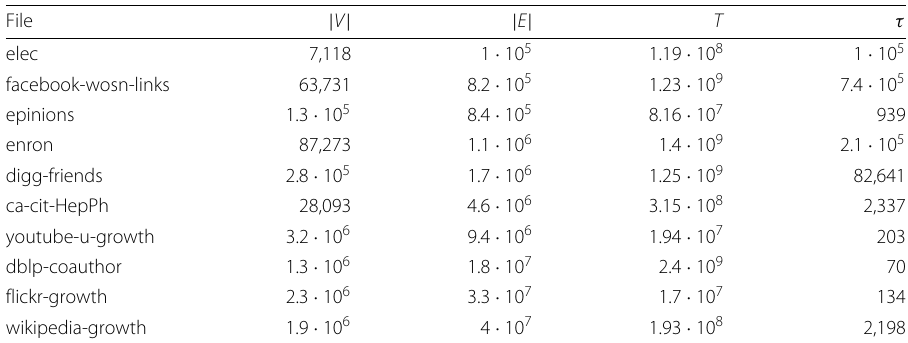
Table 2 Statistics for the real-world data sets used in our experiments (same freely available data sets as used by Wu et al. (2016), taken from the KONECT library (KONECT 2017)). The column “ T ” shows the lifetime of the temporal graph (after factoring out the precision in which time-arcs are measured) and the column “ τ ” shows the number of time steps of the graph for which there exists at least one